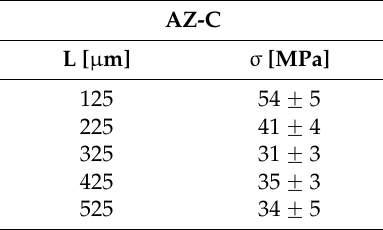
Table 2. Values of tensile stress of strings with different lengths (nominal lengths defined